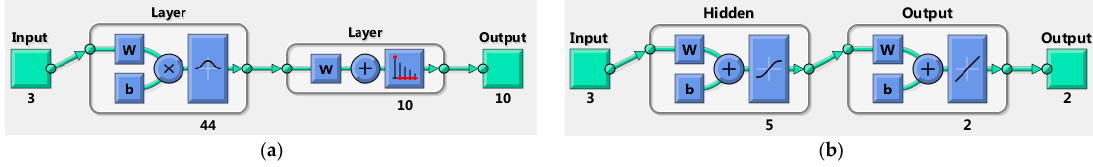
Figure 5 . Ratiometric decoding structures of ( a ) Probabilistic Neural Network (PNN) and ( b ) Multilayer Perception Neural Network (MLPNN).